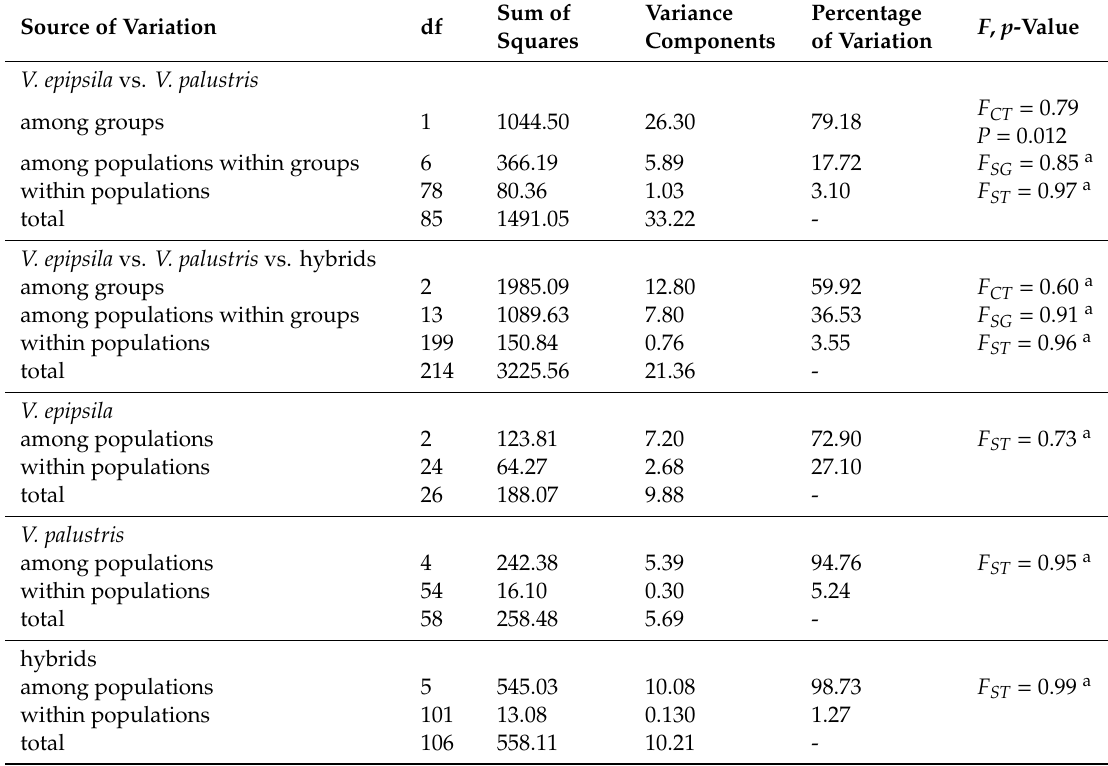
Figure 7. Results of analyses on 10 populations of V. epipsila , V. palustris , and their putative hybrid: STRUCTURE at K = 2 ( A ) and NewHybrids ( B ). Origin of samples: Germany (N), Poland (BAL, BNP, KR, KOZ, OST, SZ) and Lithuania (L). Detailed information in Table S1. Table 3. Results of the three-level AMOVA, based on ISSR profiles scored from total of 10 populations of V. epipsila , V. palustris , and their putative